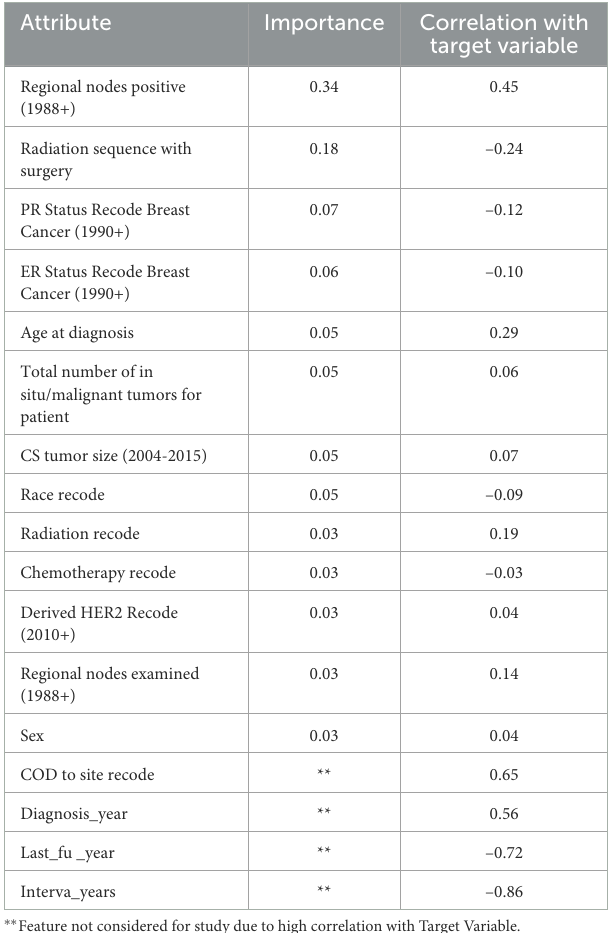
TABLE 2 Attribute importance and correlation with target